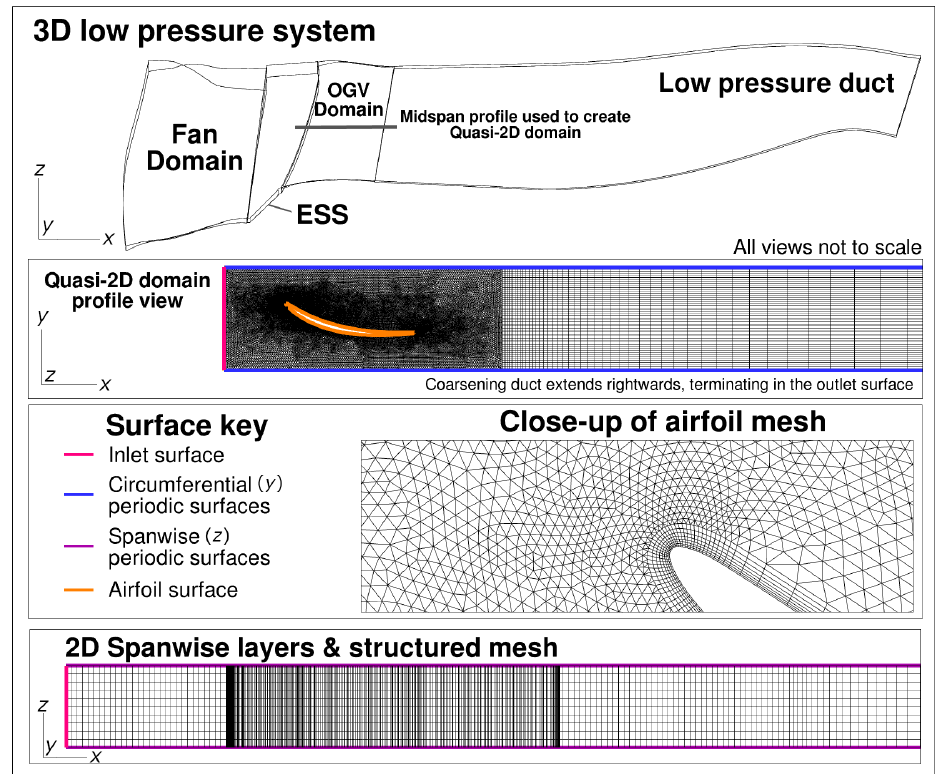
Figure 4. 3D OGV within low pressure system and translation to quasi-2D